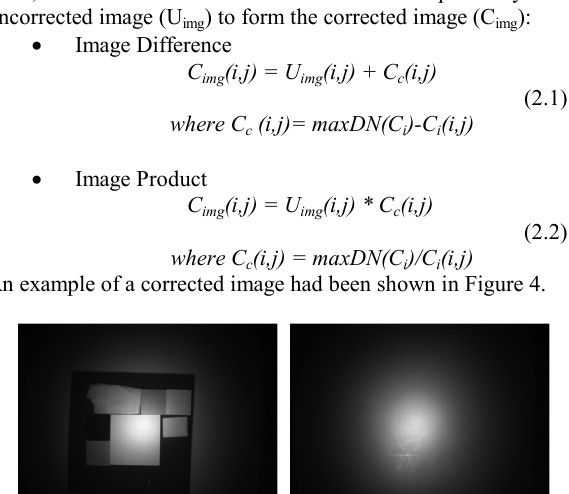
Figure 1. Imagery acquired with different exposure parameters ensuring 90%, 60% and 30% reflection from the white reference panel (in the centre of the image).